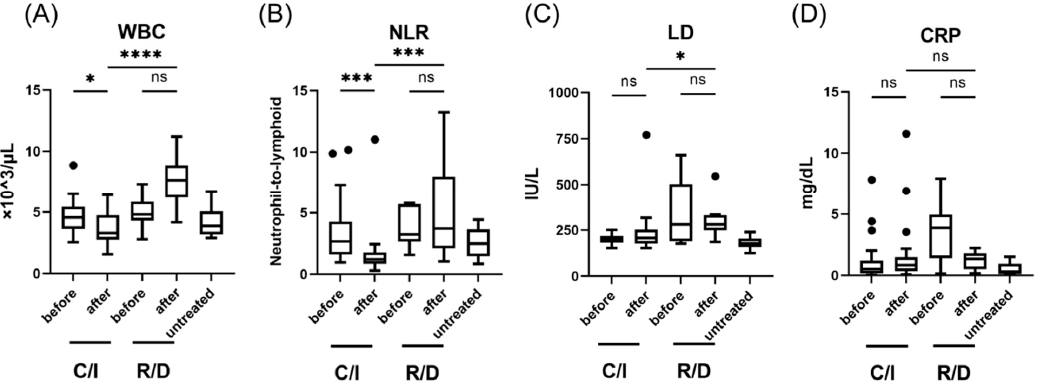
Figure 2. Laboratory findings in patients with SARS-CoV-2 infection, treated in the early phase (within 5 days after the onset of symptom); WBC ( A ), NLR ( B ), LD levels ( C ), and CRP levels ( D ). Each level was evaluated at the time point before and after the treatment; within 24 h before the initiation of therapy, 3 days after C/I administration or 5 days after R/D initiation. Data are presented as Tukey boxplots and individual values. Non-parametric Mann–Whitney test with Bonferroni correction was used to compare values between groups. *, p < 0.05. ***, p < 0.001. ****, p < 0.0001. C/I, casirivimab/imdevimab group; NLR, neutrophil-to-lymphoid ratio; ns, not significant; R/D, remdesivir/dexamethasone group; WBC, white blood cell count.